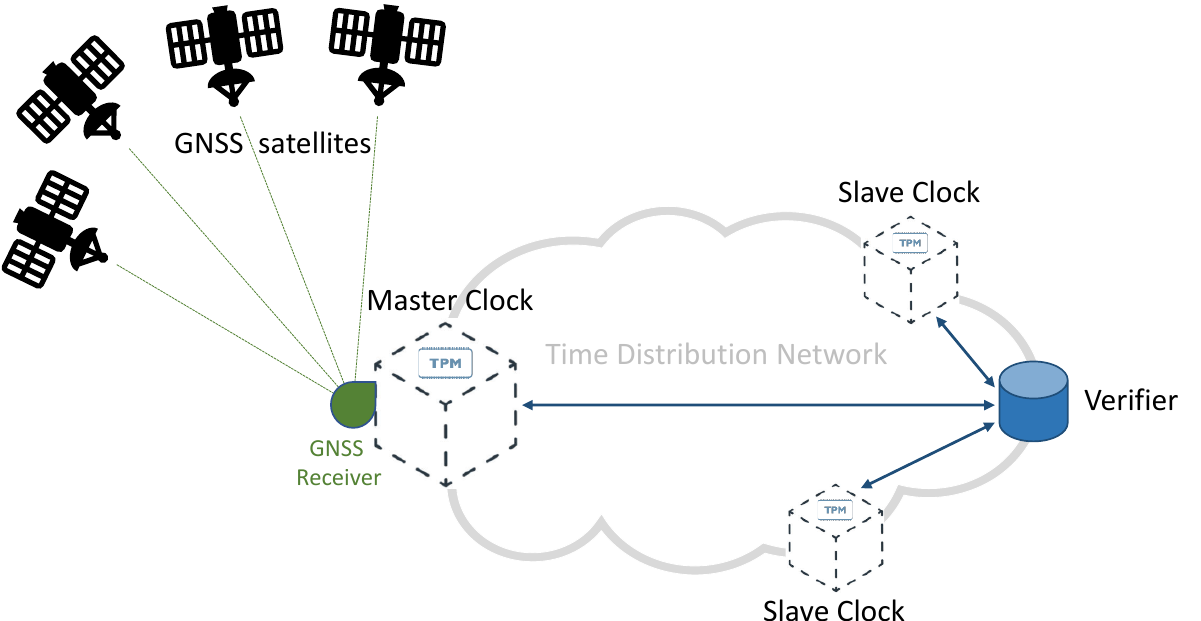
Figure 5. Architecture for Remote Attestation on the time distribution